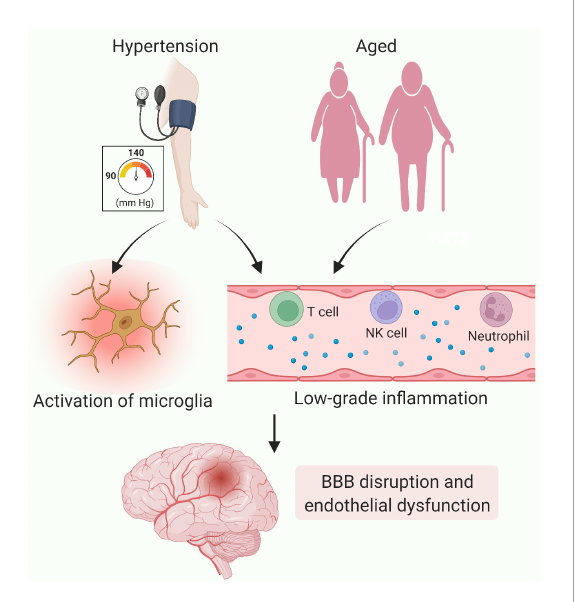
FIGURE3 Contributions of inflammation to cerebral small vessel disease (CSVD). Chronic hypertension-induced vascular remolding leads to hypoxia and ischemia of local brain parenchyma, thereby triggering activation of microglia. In addition, hypertension and aging can generate chronic, low-grade inflammation. The inflammatory molecules generated and immune cells recruited as a result contribute to BBB impairment and endothelial dysfunction. Figure created using